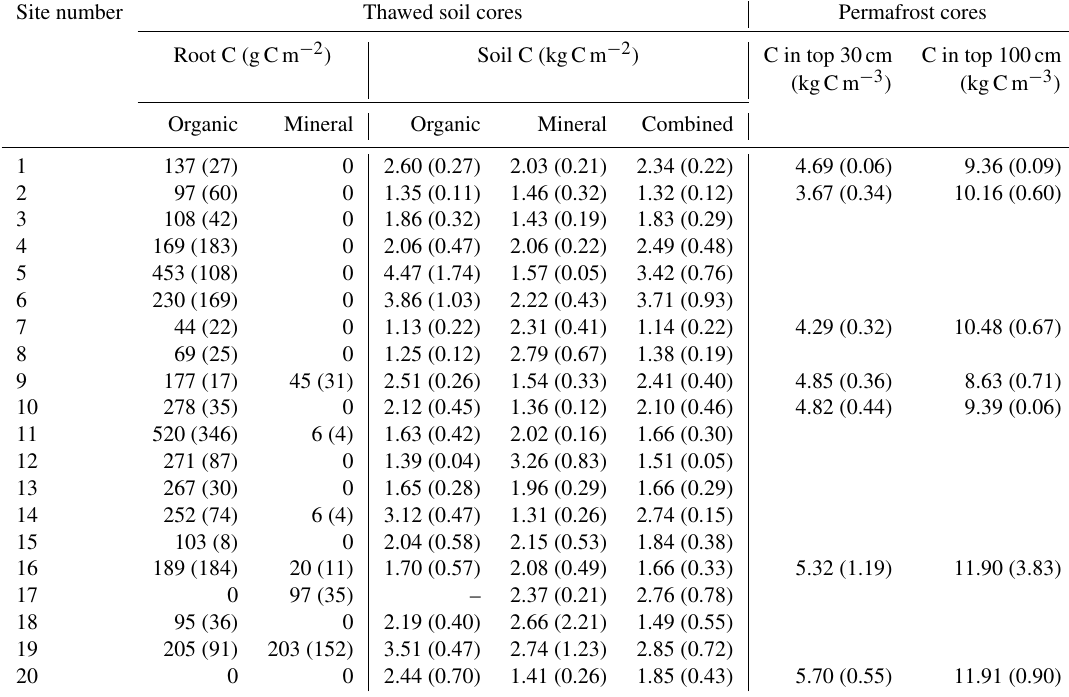
Table 4. Soil carbon in the Y4 watershed. Thawed soil cores were sampled from six locations per site. Permafrost cores were sampled to 1m at seven sites (three per site). Root C and soil C values were normalized to 10cm. The combined soil C value is the amount of C in the top 10cm of soil, regardless of soil type (mineral/organic). Carbon pools from the permafrost cores include active-layer soil (0–30 or 0–100cm from top of ground surface). Values in parentheses are standard error of the